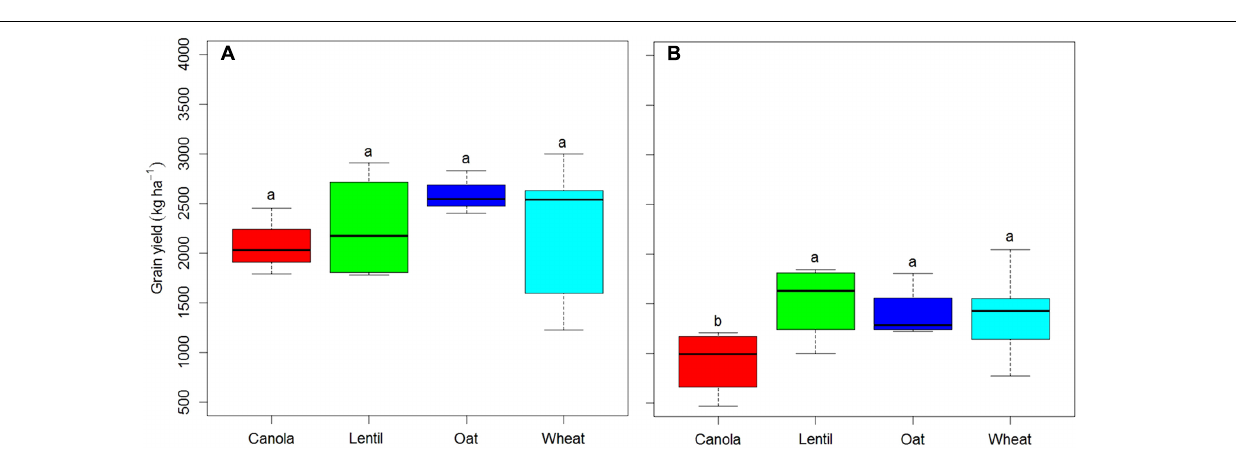
FIGURE 2 | Boxplot showing pea grain yield under various previous crops in 2015 (A) and 2016 (B) at Indian Head, SK. Horizontal lines associate with boxes represent the median interquartile range; whiskers represent the range observed. Error bars with different letters indicate a significant difference at P < 0.05.